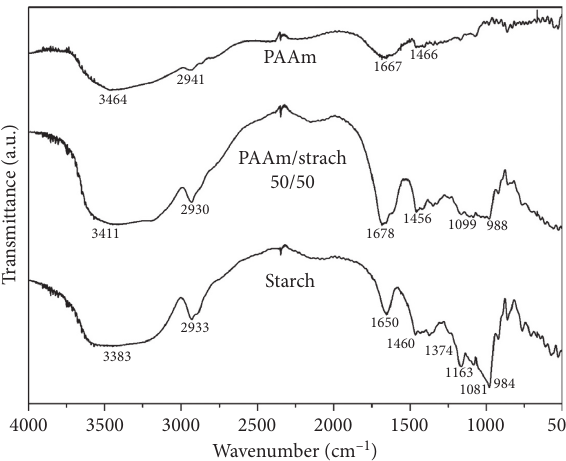
Figure 4: FTIR spectrum of PAAm hydrogel, pure starch, and PAAm/starch hydrogel